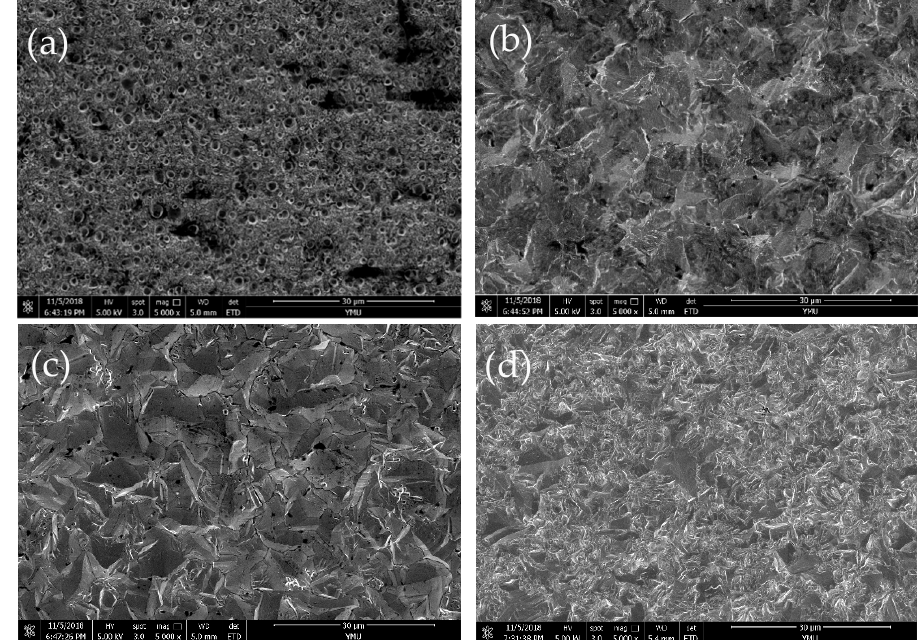
Figure 6. SEM images of Fe–Ni alloys electrodeposited from the chloride baths that contained 0.1 M